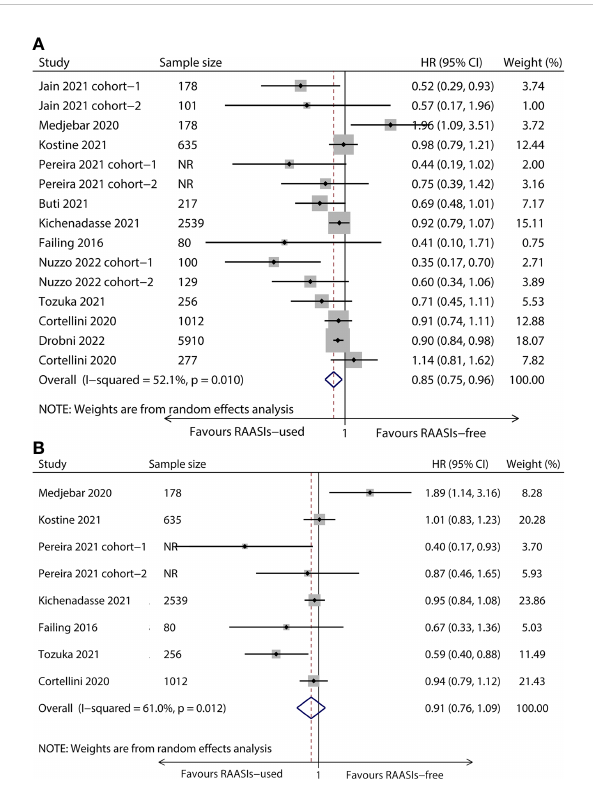
FIGURE 2 Forest plot of OS and PFS comparing RAASIs-used and RAASIs-free patients treated with ICIs. Pooled HR for OS (A) and PFS (B) . OS, overall survival; PFS, progression-free survival.